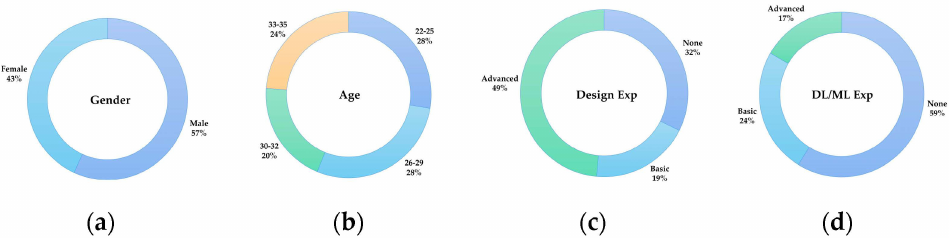
Figure 7. Profile distribution of the participants of our user study; ( a ) Age, ( b ) Gender, ( c ) UI design experience, ( d ) Deep Learning/Machine Learning experience.